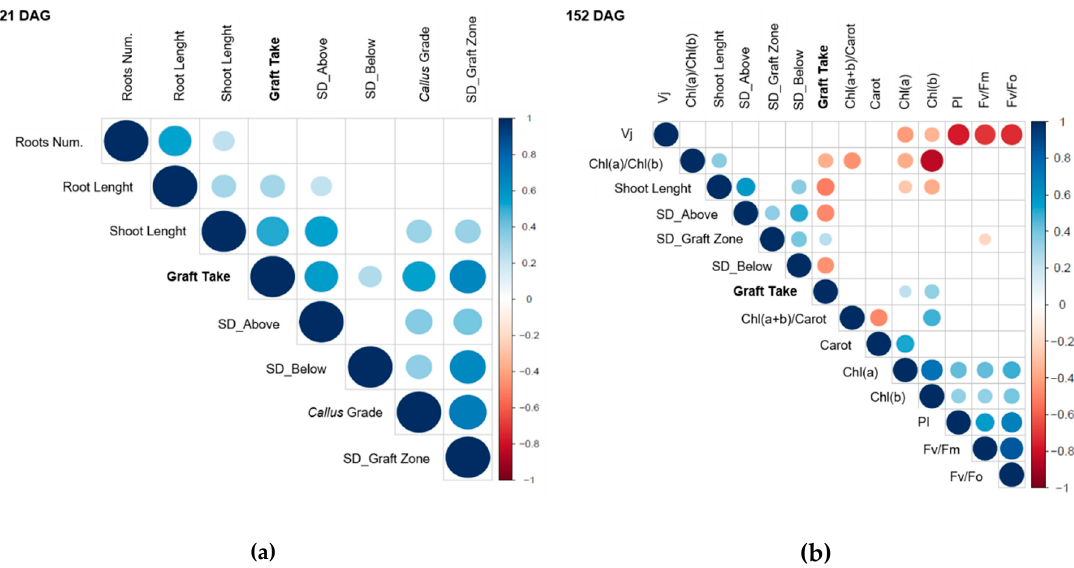
Figure 3. Pearson correlation of the graft take value versus all the parameters investigated at 21 and 152 DAG. ( a ) at 21 DAG: roots number, length of the major root, shoot length, stem diameters (SD) above, below and at the graft zone and callus score. ( b ) Pearson correlation of the graft take values versus the parameters investigated at 152 DAG: shoot length, stem diameter (SD) above, below and at the graft zone, Chlorophyll a (Chl(a)), Chlorophyll b (Chl(b)), carotenoids (Carot), ratio Chl(a) and Chl(b), ratio total chlorophylls and Carot, and the following chlorophyll fluorescence values: Vj, PI, Fv / Fm, Fv / Fo. Positive correlations are displayed in blue and negative correlations in red colors. The size of the circles and color intensities are proportional to the correlation coefficients. Correlations with p value > 0.01 are considered insignificant and are left blank.